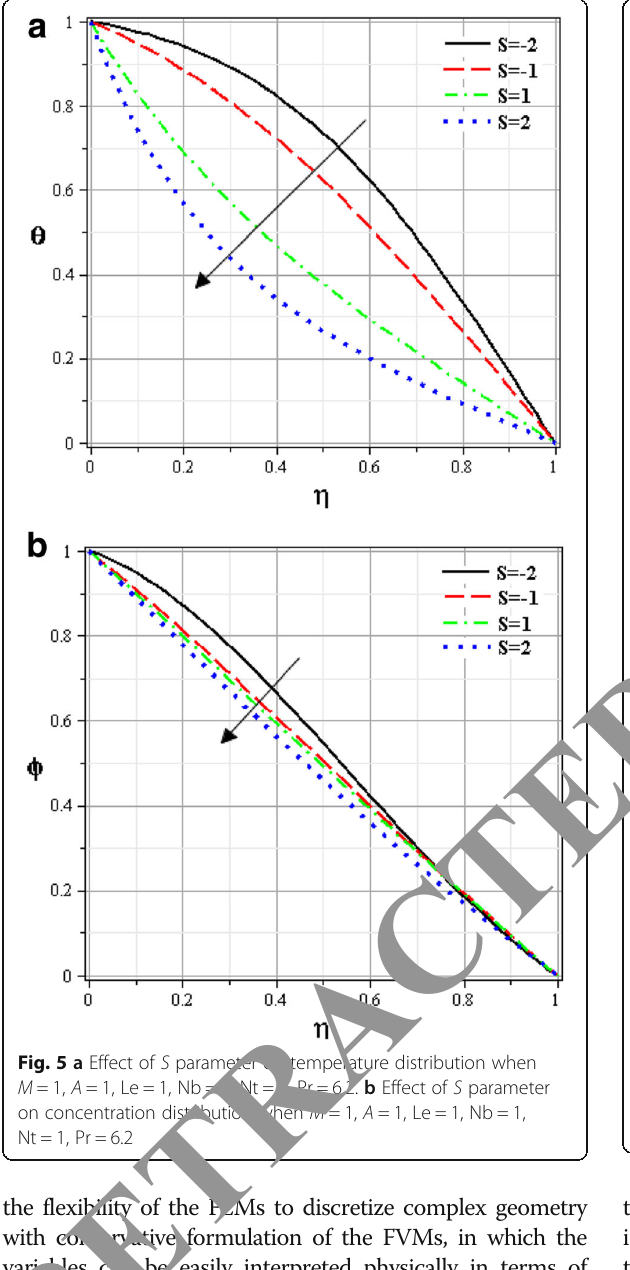
Fig. 5 a Effect of S parameter on temperature distribution when M = 1, A = 1, Le = 1, Nb = 1, Nt = 1, Pr = 6.2. b Effect of S parameter on concentration distribution when M = 1, A = 1, Le = 1, Nb = 1, Nt = 1, Pr =